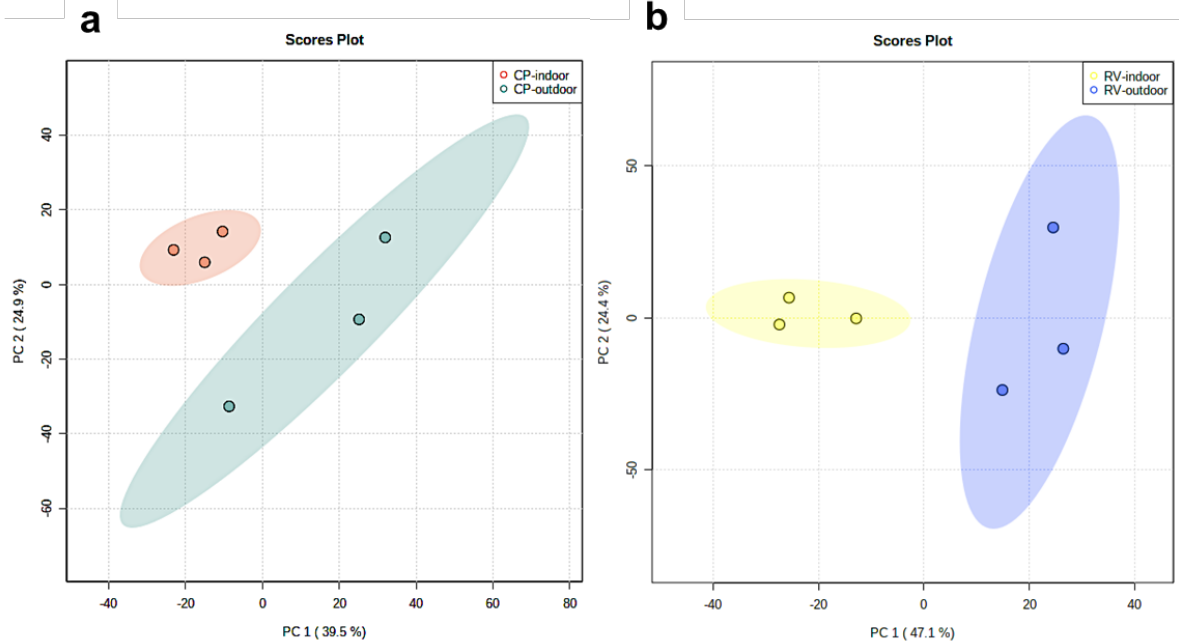
Figure 1. Principal component analysis (PCA) score plots of the extracted metabolic features obtained by untargeted LC-MS analysis in the negative ionization mode ( a ) CP-indoor (red color) and CP-outdoor (green color) and ( b ) RV-indoor (yellow color) and RV-outdoor (blue color).